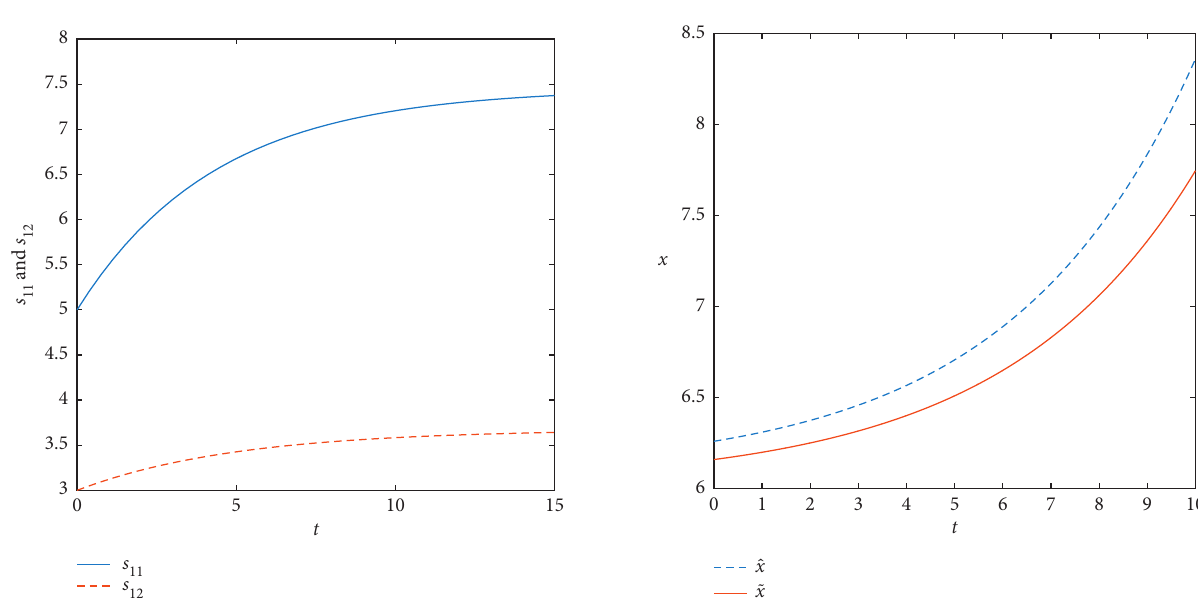
Figure 16: The pollution abatement investment trajectory of both regions under noncooperation and